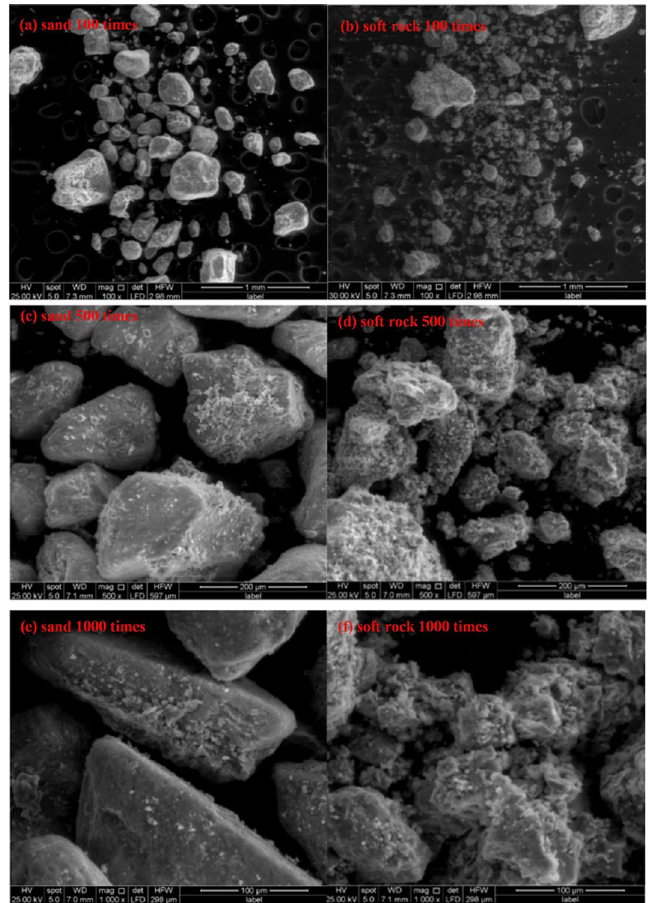
Figure 1. Scanning electron microscope images of sand and soft